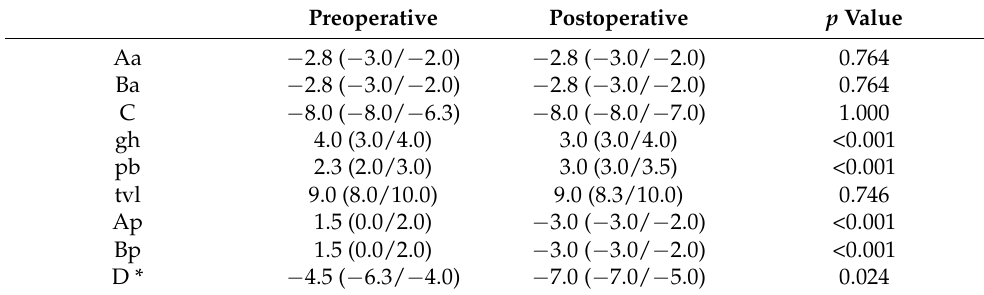
Table 3. Preoperative versus postoperative POP-Q comparison. * only for patients with uterus.